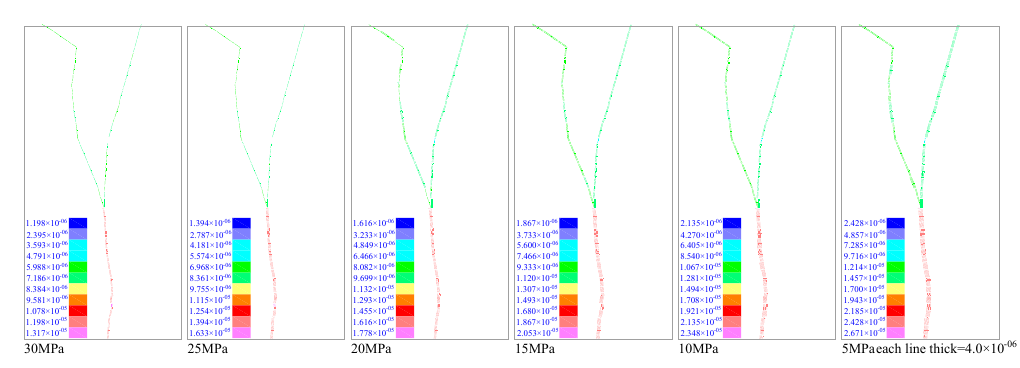
Figure 25. Joint hydraulic aperture.